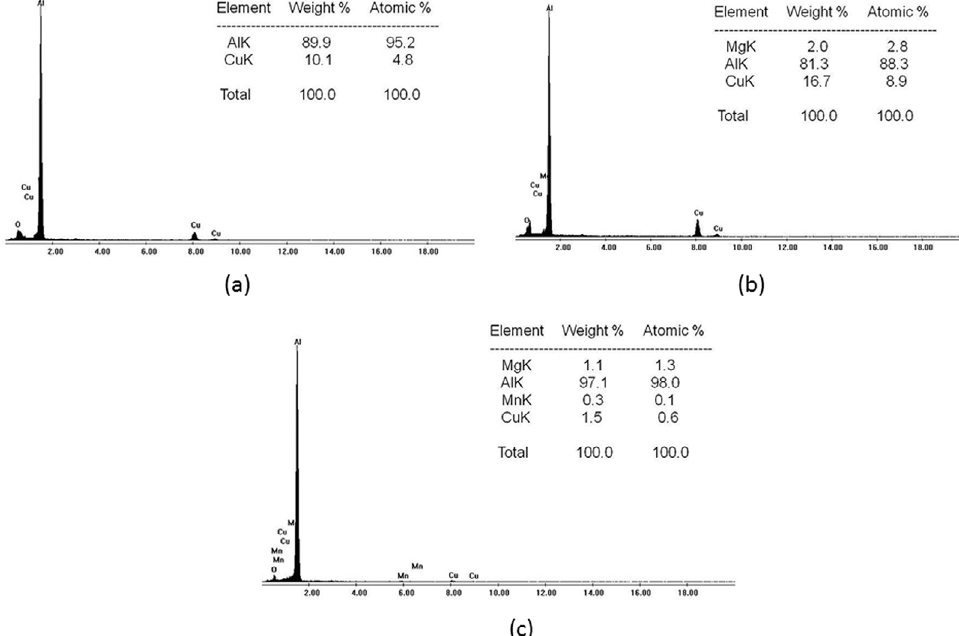
Figure 11. EDS microanalysis results verifying the chemical composition of the (a) θ and (b) S phases and (c)